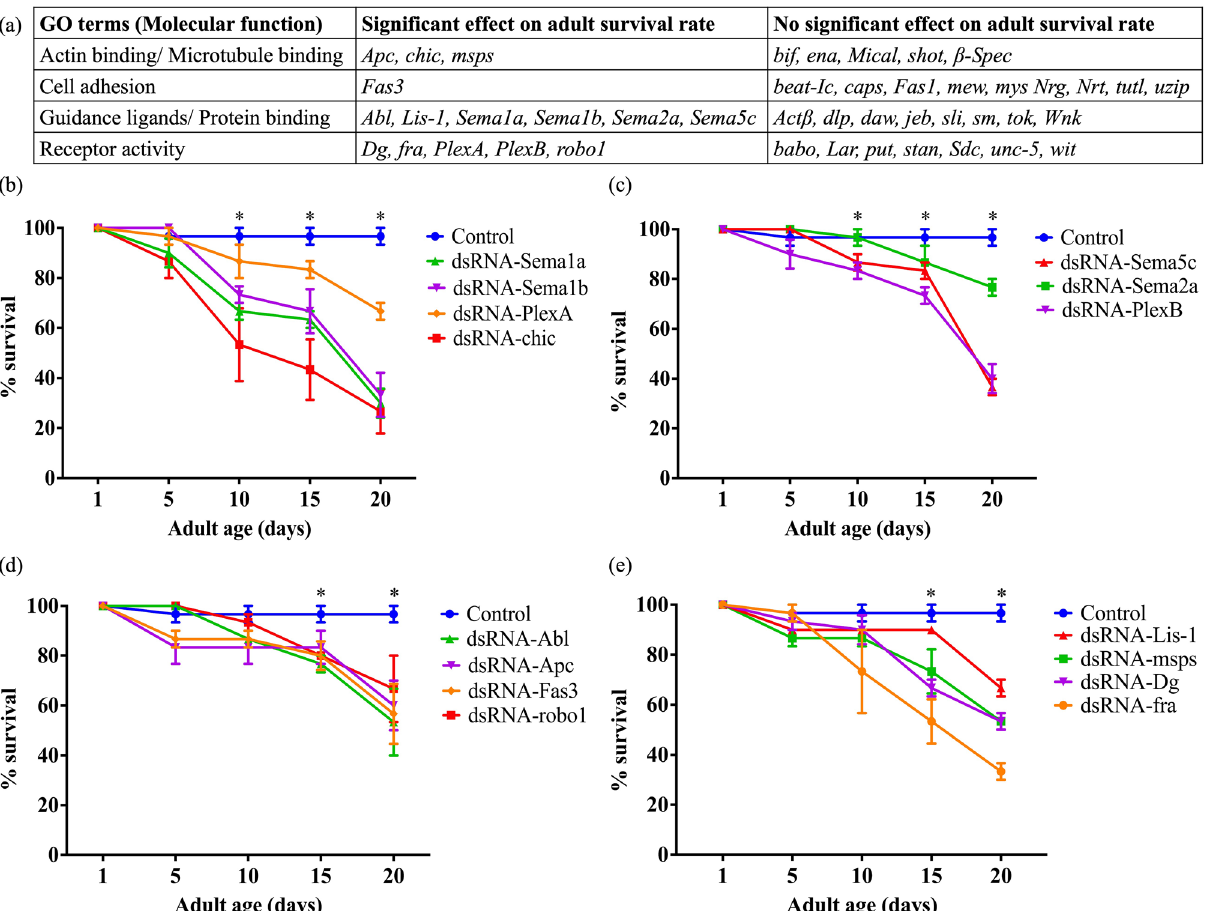
Figure 1. Knockdown of a subset of axon guidance genes reduces adult survival rate. ( a ) A summary of the axon guidance genes that were tested for the impact of knockdown on adult survival rate using the GeneSwitch screen. The axon guidance cues are categorized into four groups based on the molecular function GO terms. ( b , c ) Survival analysis curves of axon guidance genes that showed a significant effect on survival from day 9 post eclosion. We note that Sema2a is not significantly different from the control on day 10 (c), however we included these flies in the graph to group the analysis of the Semaphorin and Plexin genes together. ( d , e ) Survival analysis curves of axon guidance genes that showed a significant effect from day 14 post eclosion. Data shown are mean ± SEM (p < 0.05, two-way ANOVA and Tukey’s multiple comparison tests; n = 30). ‘*’ indicates the time points when the survival of knockdowns was significantly different from that of the